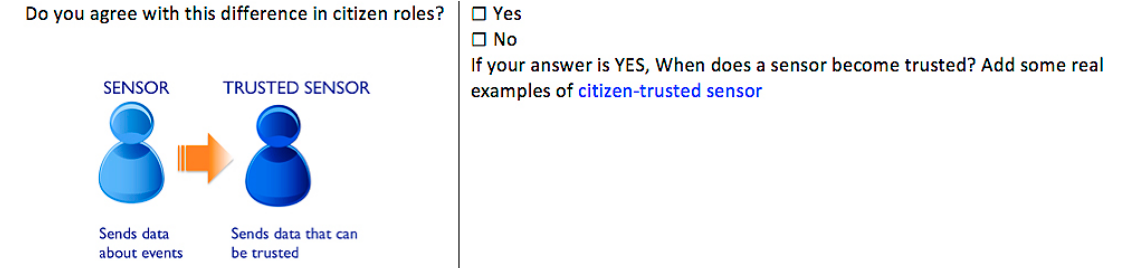
Figure 1. Example of a question in the focus group about citizen roles.